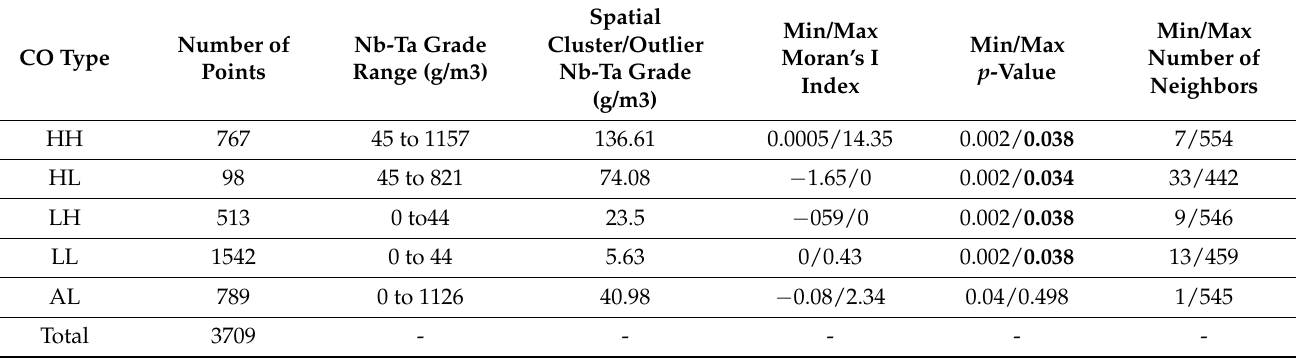
Table 4. Results of Moran’s statistical